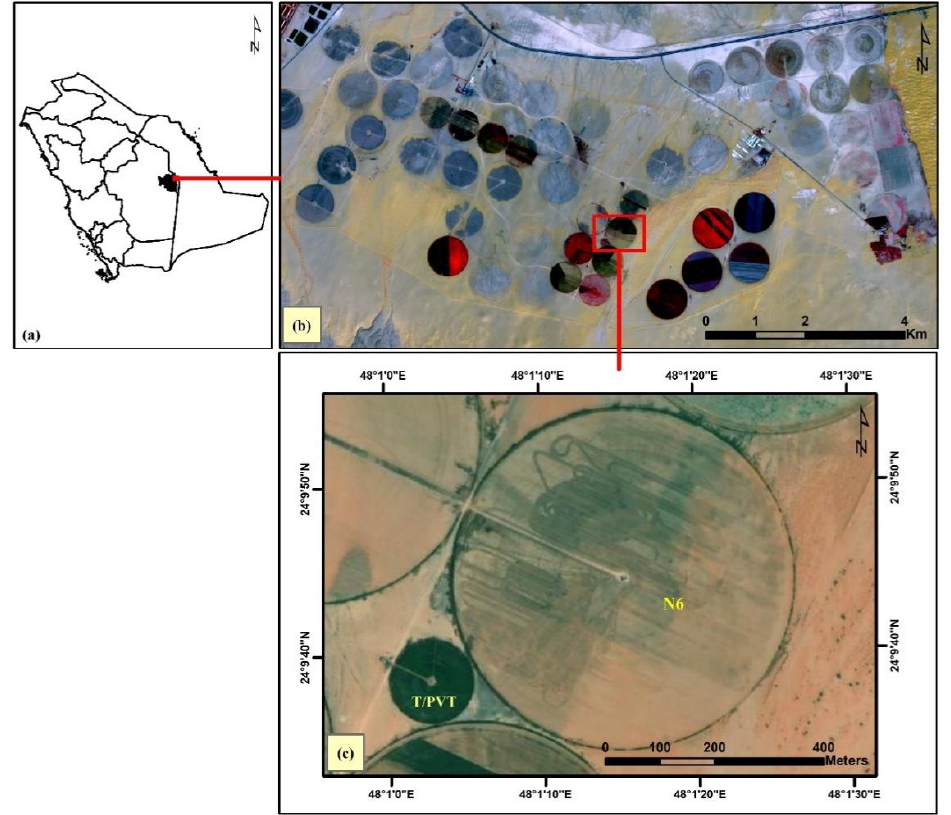
Figure 1. Location of Tawdeehiya Farms, central region of Saudi Arabia. ( a ) Al-Kharj region overlaid on Kingdom of Saudi Arabia; ( b ) extent of experimental farm; and ( c ) experimental fields T/PVT and N6 cultivated with onion and carrot crops, respectively.